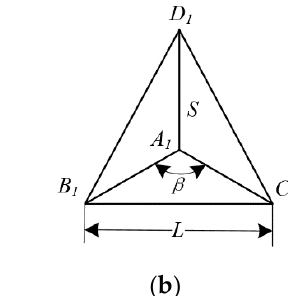
Figure 1. Origami element of triangular pyramid. ( a ) Front view; ( b ) top view.